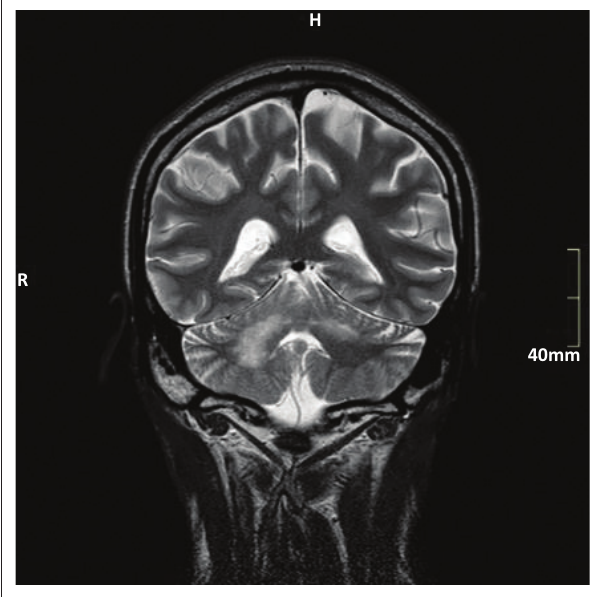
FIGURE 3: Coronal T2 weighted image of the patient discussed in Case 3, showing high-signal in both cerebellar hemispheres with greater involvement of the right